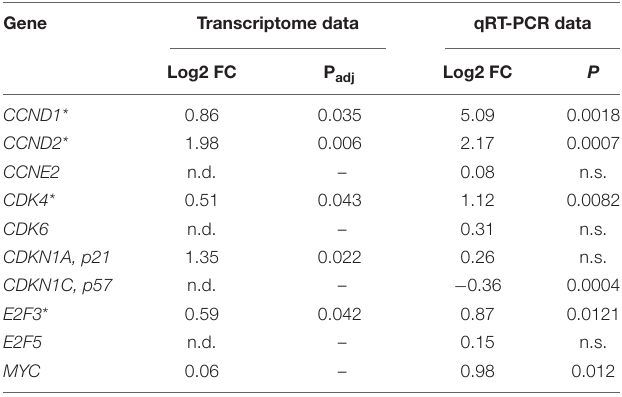
TABLE 1 | Gene expression of 10 G0/G1 cell cycle-related genes obtained from the transcriptome analysis (BeadChip) and validated by qRT-PCR analysis. Gene Transcriptome